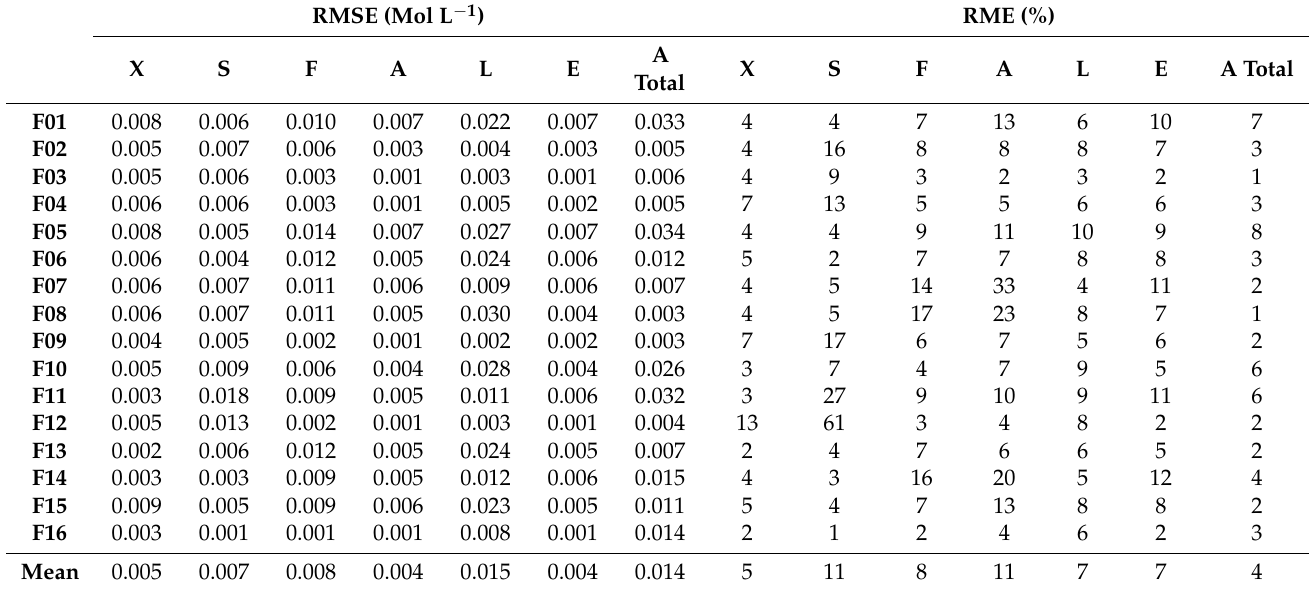
Table A1. Residual modelling error with model parameters determined for each experiment and summarized in Table